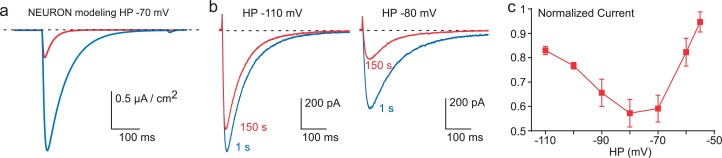
Inhibition of Cav3.3 current as a function of the HP.(a) Simulation of the Cav3.3 current at −30 mV from an HP of −70 mV. The Cav3.3 current was modeled from experiments presented in Figure 3. The blue trace corresponds to the Cav3.3 current properties obtained before the 1 Hz stimulation whereas the red trace corresponds to the Cav3.3 current properties obtained after 40 s stimulation at 1 Hz. (b) Cav3.3 current elicited at a frequency of 0.2 Hz from a HP of −110 mV (left panel) and a HP of −80 mV (right panel). (c) Inhibition of Cav3.3 current after 150 s stimulation as a function of the HP (n = 5–8 per point).